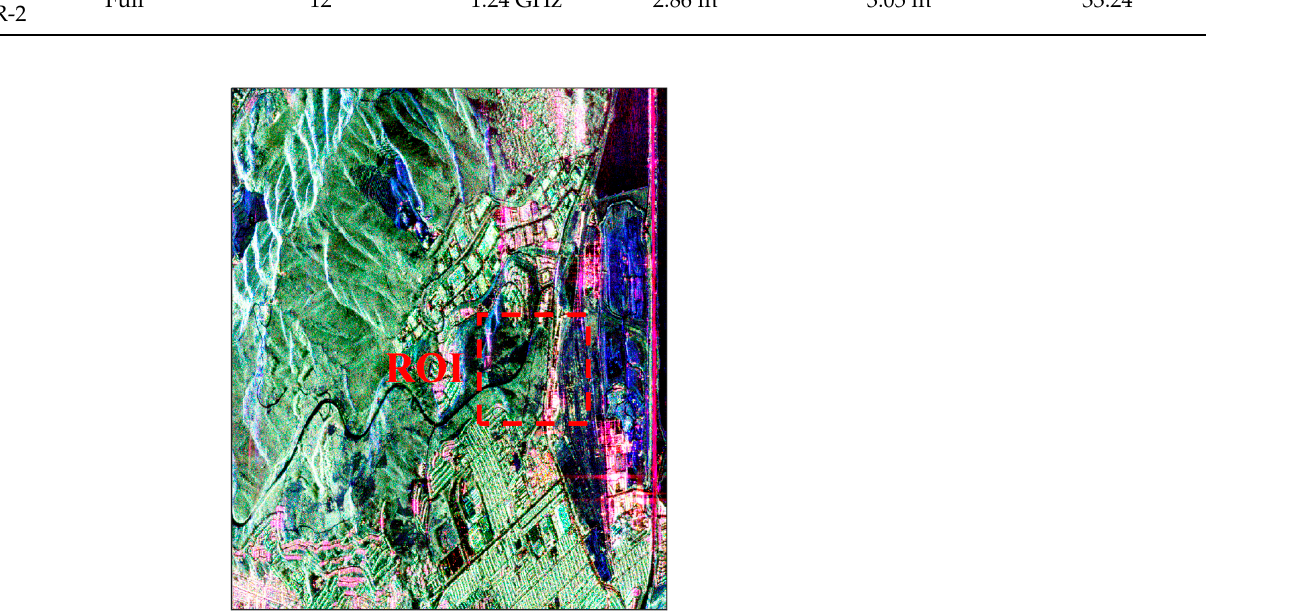
Table 1. Image Parameter List of Time-Series ALOS PALSAR-2 Full Polarimetric SAR data. Sensor